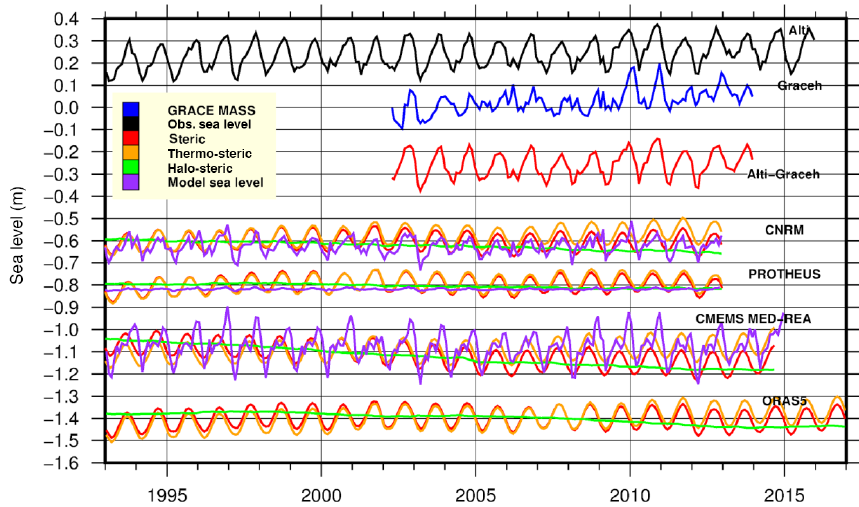
Figure 15. From top to bottom, basin average of altimeter sea level, GRACE mass change, steric derived from altimeter sea level and mass component, steric and sea level components of two simulations, and a regional model reanalysis and a global model